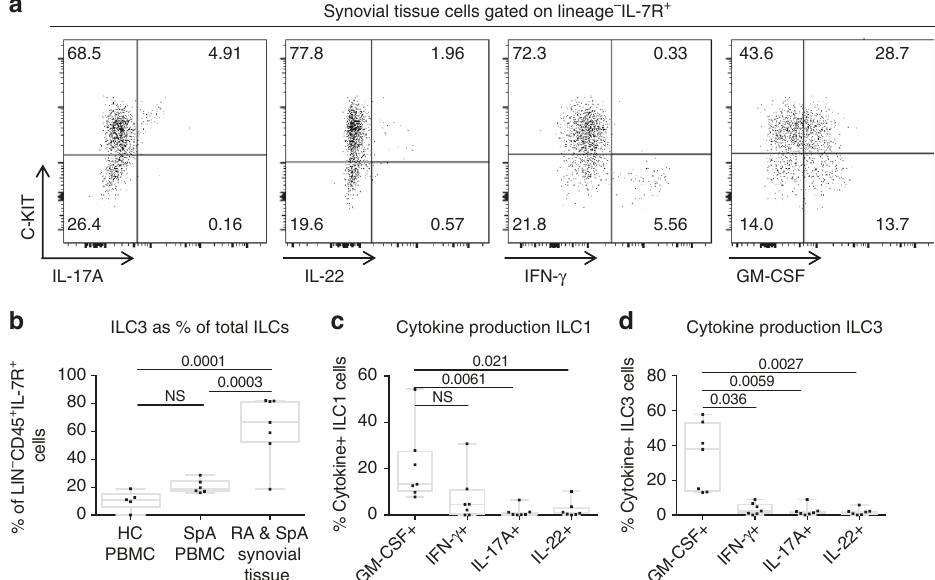
Fig. 3 Type 3 innate lymphoid cells (ILC3) are enriched in in fl ammatory arthritis synovial tissue and produce GM-CSF. a Representative fl ow cytometry plots showing cytokine production by synovial ILCs. Lineage negative (Gating strategy shown in Supplementary Fig. 5. Lineage cocktail: CD3, CD5, CD8, CD11b, CD11c, CD19, CD20, CD34, TCR- γδ , CRTH2) CD45 + cells were then gated on IL-7R expression. ILC1 subset de fi ned as Lin − CD45 + IL-7R + C-KIT − and ILC3 subset de fi ned as Lin − CD45 + IL-7R + C-KIT + . b Relative enrichment of ILC3s as percentage of total ILCs in in fl ammatory arthritis synovial tissue explant cultures ( n = 7), compared to ex vivo PBMCs from axial spondyloarthritis (SpA) ( n = 6) and healthy control ( n = 5) (ANOVA). c , d . Intracellular expression of GM-CSF IFN- γ , IL-17A and IL-22 in stimulated ILCs plotted against C-KIT expression to identify ILC1 and ILC3 cytokine production ( n = 7 patients with in fl ammatory arthritis, 4 SpA/3 RA) (Friedman ’ s multiple comparison